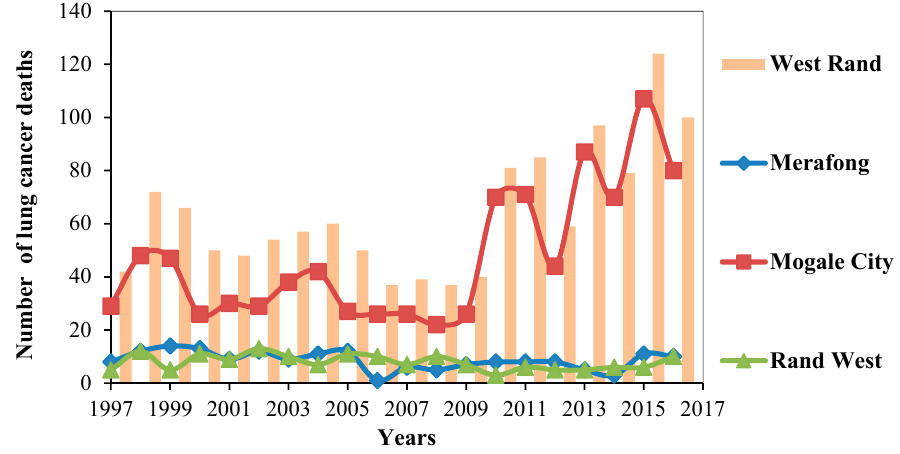
Figure 12. Lung cancer deaths in various municipalities of the West Rand, whereby the Mogale City Local Municipality show higher rates than Merafong and Rand West Local Municipality (Data source: StatsSA).